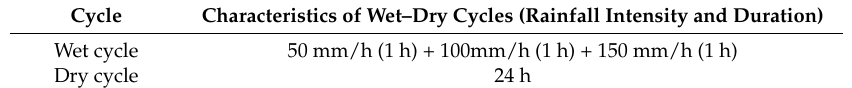
Table 1. Characteristics of wet and dry cycles applied over the specimens in terms of rainfall intensity, and duration of each cycle.